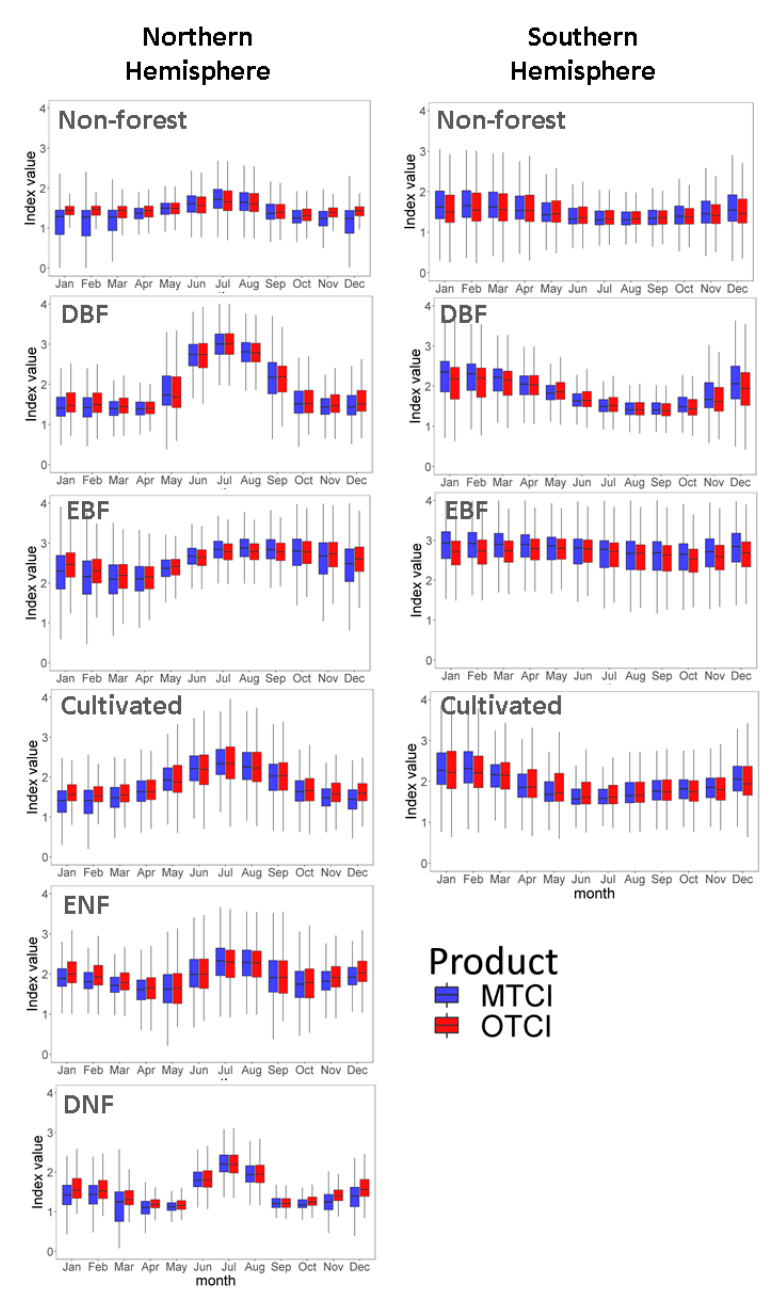
Figure 8. Monthly evolution of Envisat MTCI (mean of 2002 to 2012) and Sentinel-3 OTCI (mean of 2016 to 2019) values by land cover for the northern and southern hemispheres. The land cover classes are: evergreen needleleaf (ENF), evergreen broadleaf (EBF), deciduous needleleaf (DNF), deciduous broadleaf (DBF), non-forest, and cultivated. The boxes embody the median, the first, and the third quartile of the long-term monthly Envisat MTCI and Sentinel-3 OTCI values. ENF and DNF are missing for the southern hemisphere because these land cover types did not have a significant number of pixels.